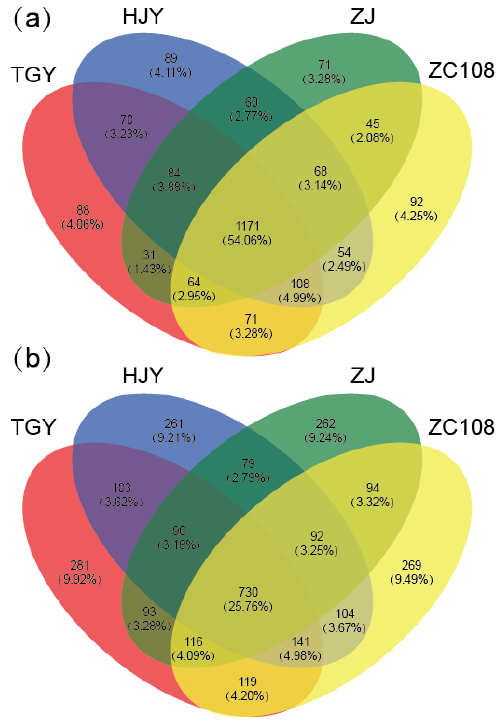
Figure 2. Venn diagram of bacterial ( a ) and fungal ( b ) OTUs in the soils with different tea cultivars. HJY, Huangjinya, TGY, Tieguanyin, ZC108, Zhongcha108, ZJ, Zijuan. Further, the microbial population from phylum to species levels that determined the richness and diversity based on Chao1 and Shannon indices were analyzed, respectively (Table 2). Overall, only bacterial populations were found to be sensitive to the tea cultivars. (family to species) among the tea cultivars, while soil bacteria at the higher taxonomic levels (phylum to order) showed no significant difference. The highest population was found